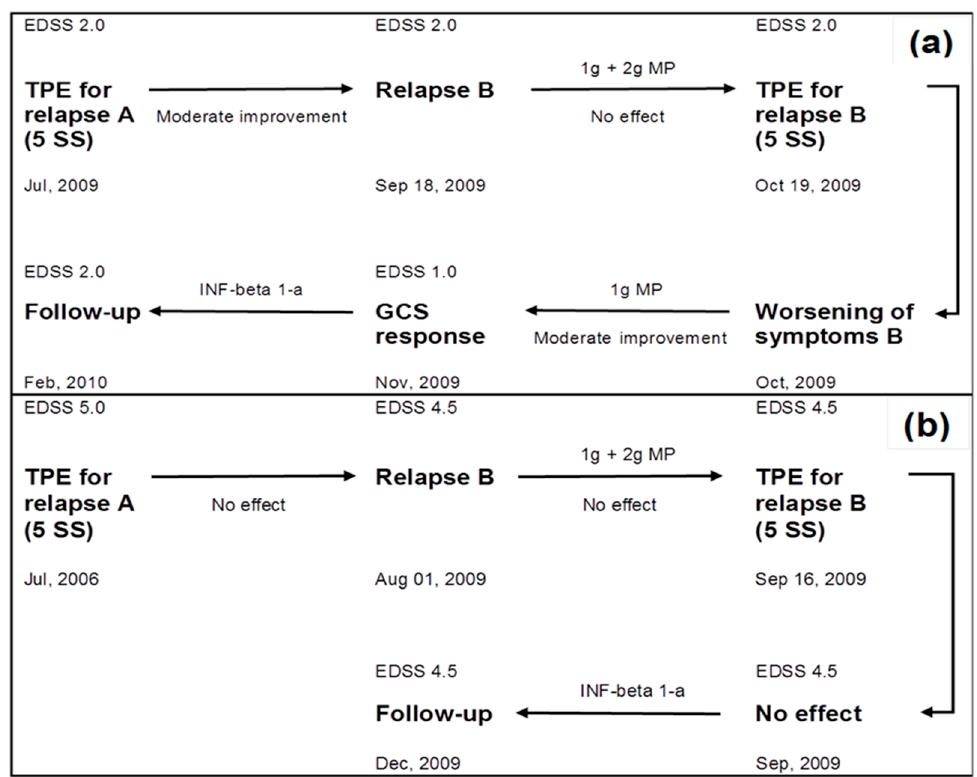
Figure 2. Extended treatment with glucocorticosteroids (GCS) and repeated therapeutic plasma exchange (TPE) in two GCS-unresponsive multiple sclerosis (MS) patients. ( a ) patient one with relapsing-remitting (RR)-MS; ( b ) patient two with a transition from clinically isolated syndrome (CIS) to RR-MS between relapse A and relapse B. Moderate improvement was defined as a definite change of the neurologic deficit without significant impact on function within the functional score, and no effect as unchanged symptoms. 5 SS: Five single sessions.